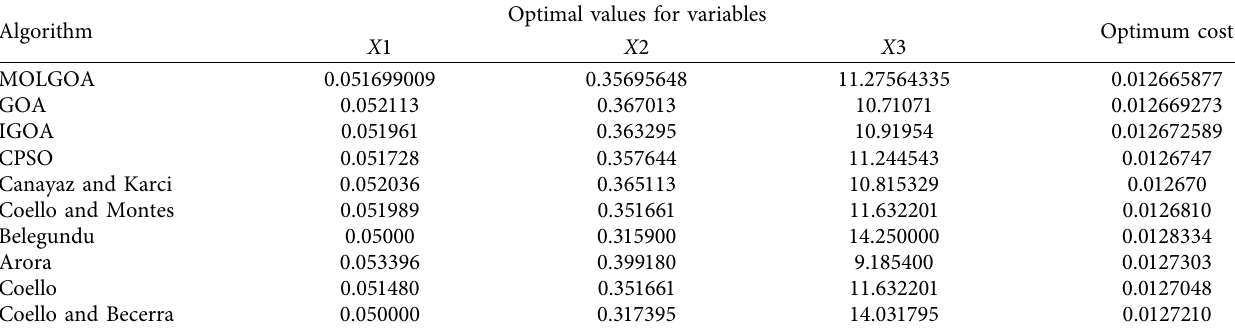
Table 13: Comparison results of the TCS problem.